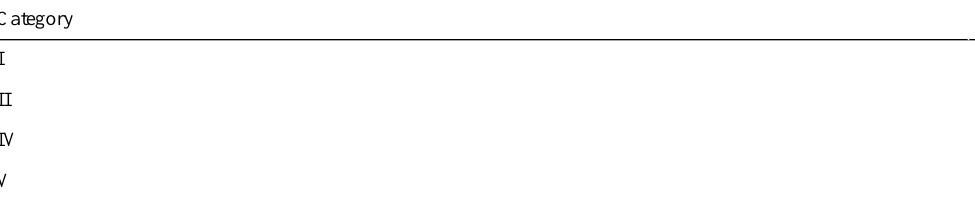
Figure 2. Study by research